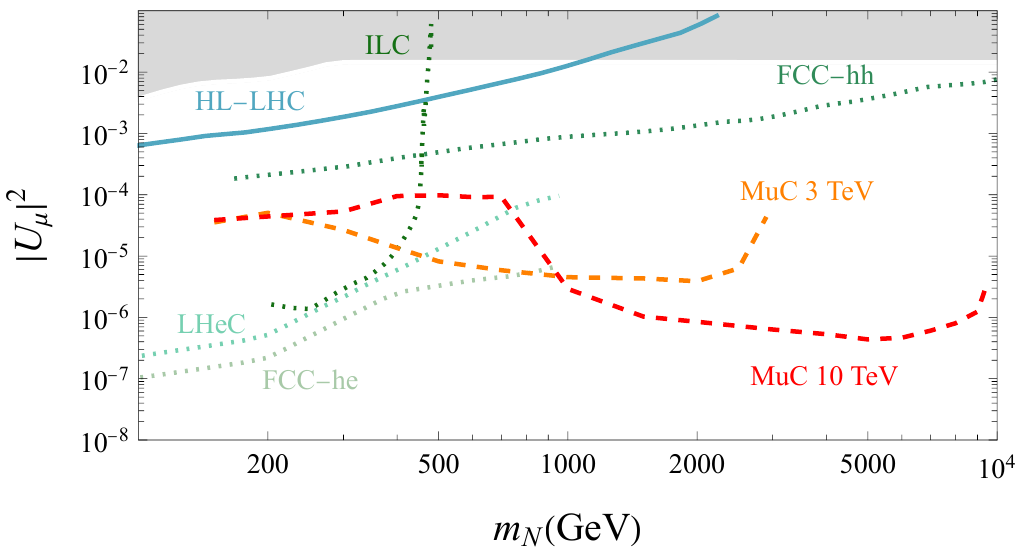
Figure 10 . The 95% exclusion limits on the | U µ | 2 – m N plane at different experimental facilities including LHC [57, 76, 117] and proposed future colliders (LHeC and FCC-he [118], FCC-hh [76, 119], ILC [53,